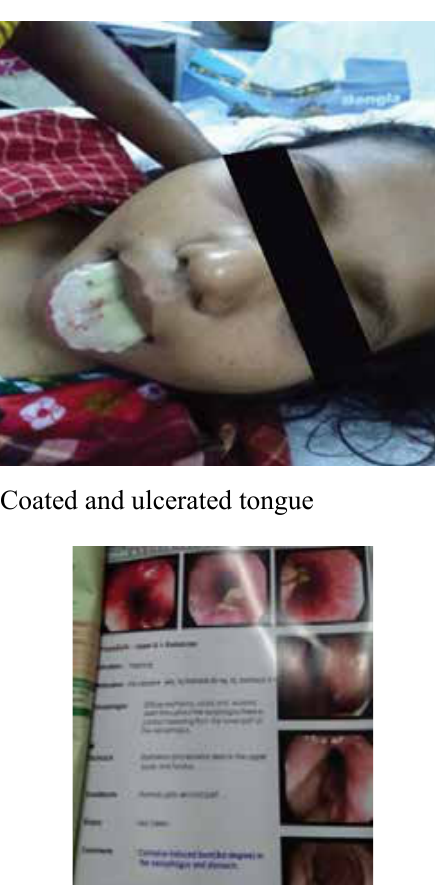
Fig 1. Sample of paraquat